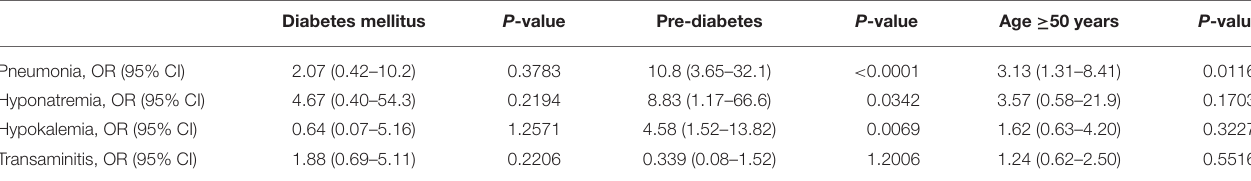
TABLE 5 | Association between age, diabetes mellitus, and pre-diabetes with complications of COVID-19. Diabetes mellitus P